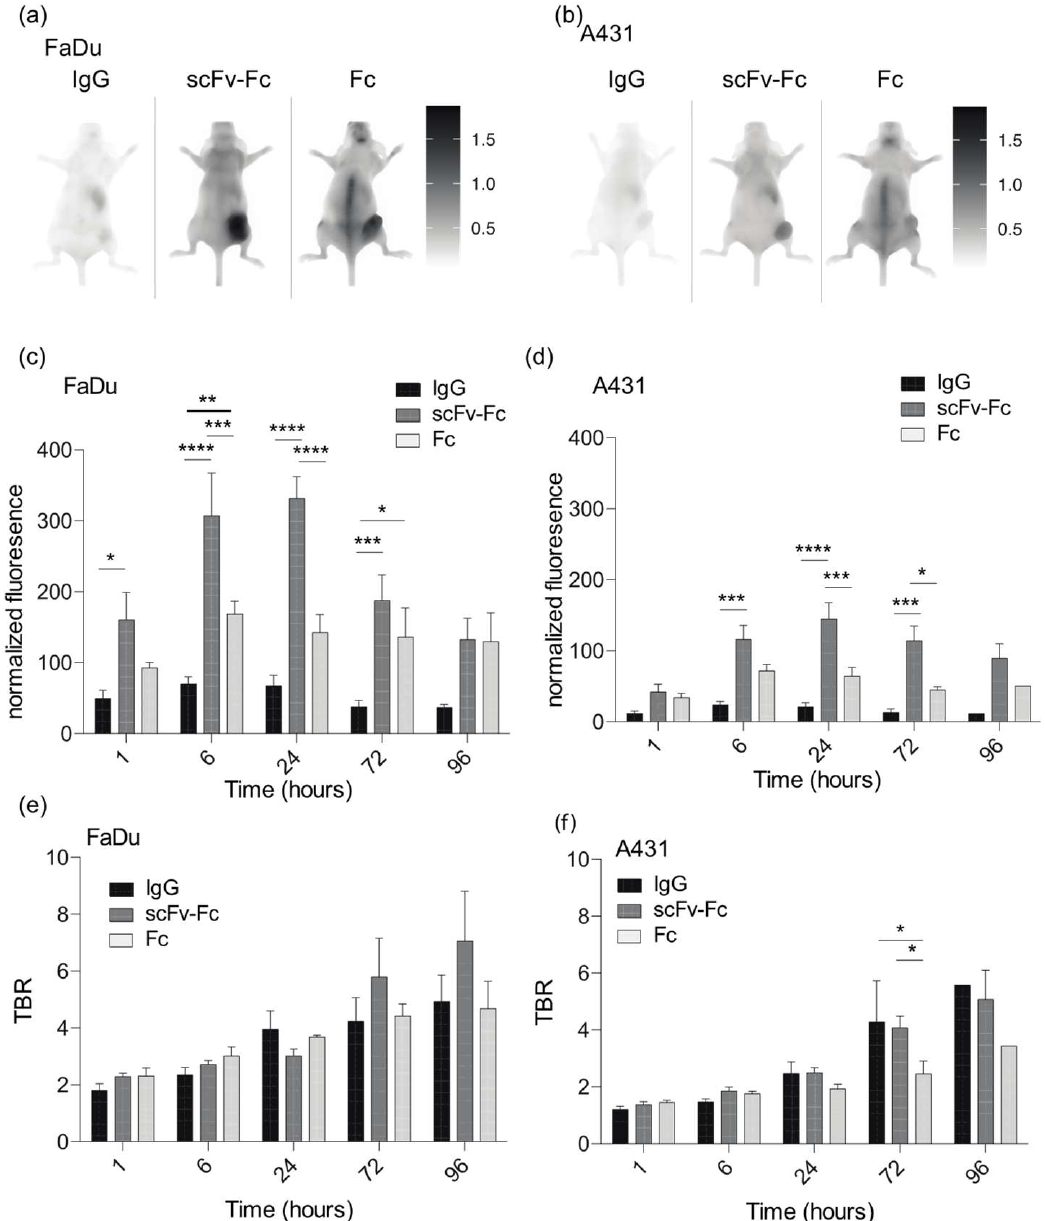
Figure 4. Imaging depends on the Fc-containing imaging probe and the xenograft. ( a , b ) IgG, scFv-Fc, and Fc domain probes were injected into CD-1 nude mice bearing FaDu or A431 xenografts and imaged over time with the 24 h image shown. ( c , d ) Normalized fluorescence and ( e , f ) tumor-to- background ratio (TBR) of mouse imaging over time. Error bars represent the standard error of the mean from at least three independent mice and p -value * represents the p -value ≤ 0.05, ** represents the p -value ≤ 0.01, *** represents the p -value ≤ 0.001 and **** represents the p -value ≤ 0.0001. In the A-431 xenograft, the scFv-Fc probe accumulated significantly more than the IgG probe at 6, 24 and 72 hpi ( p -value ≤ 0.001 at 6 and 72 hpi and p -value ≤ 0.0001 at 24 hpi) (Figure 4d) and significantly more than the Fc domain probe at 24 and 72 hpi ( p -value ≤ 0.001 and 0.05, respectively). The Fc domain probe did not accumulate at high levels in A-431 cells (MFI < 72 at all time points). Accumulation of the scFv-Fc probe in A-431 cells peaked at 24 h with an MFI of 145 ±